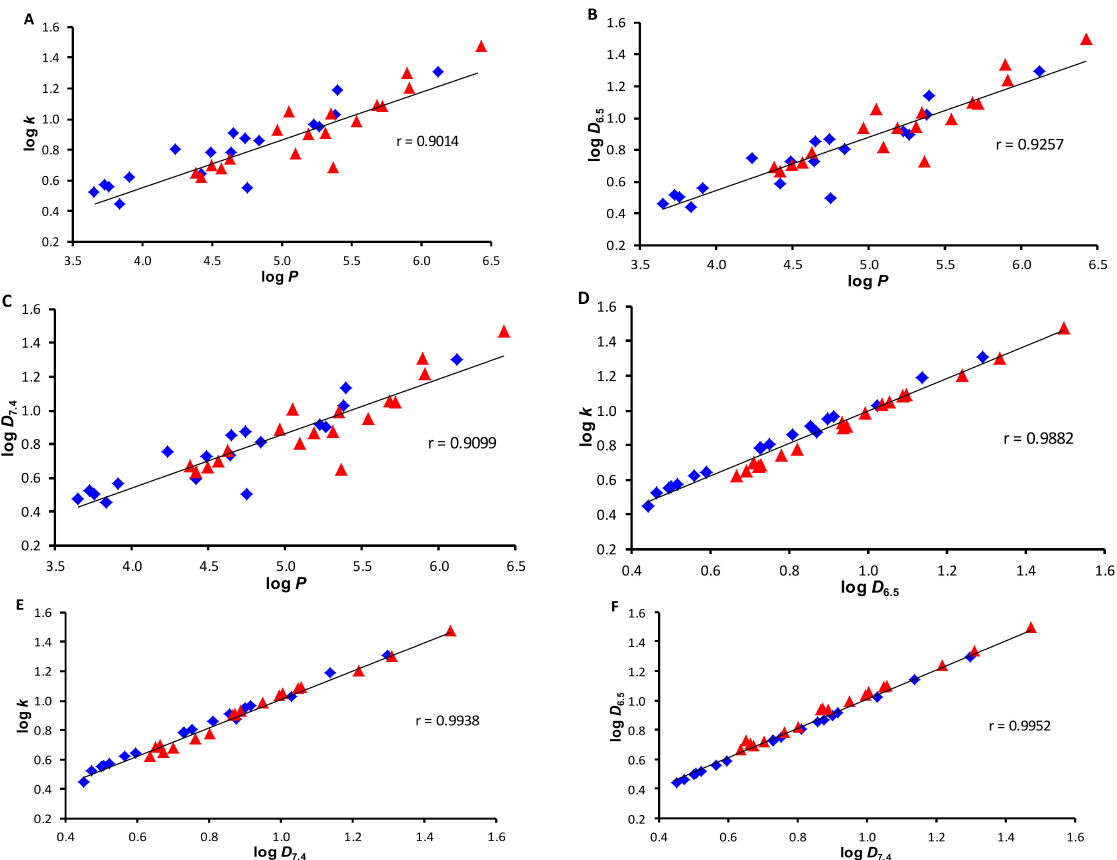
Figure 1. Comparison of predicted log P (ACD/Percepta) values with experimentally determined values of log k ( A ), log D 6.5 ( B ), log D 7.4 ( C ), and mutual correlation ( D – F ) of all prepared compounds 1a – 2r . (blue rhombuses = series 1 , red triangles = series 2